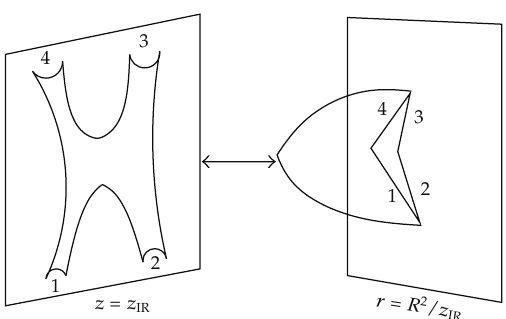
Figure 2: Comparison of the world-sheet in original and T -dual coordinates. The hyperplane on the picture to the right should not be interpreted as a D -brane.